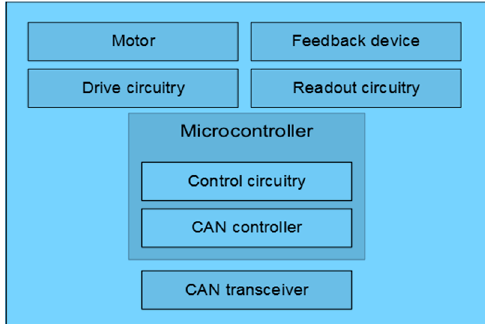
Figure 5. Underwater actuator configuration.